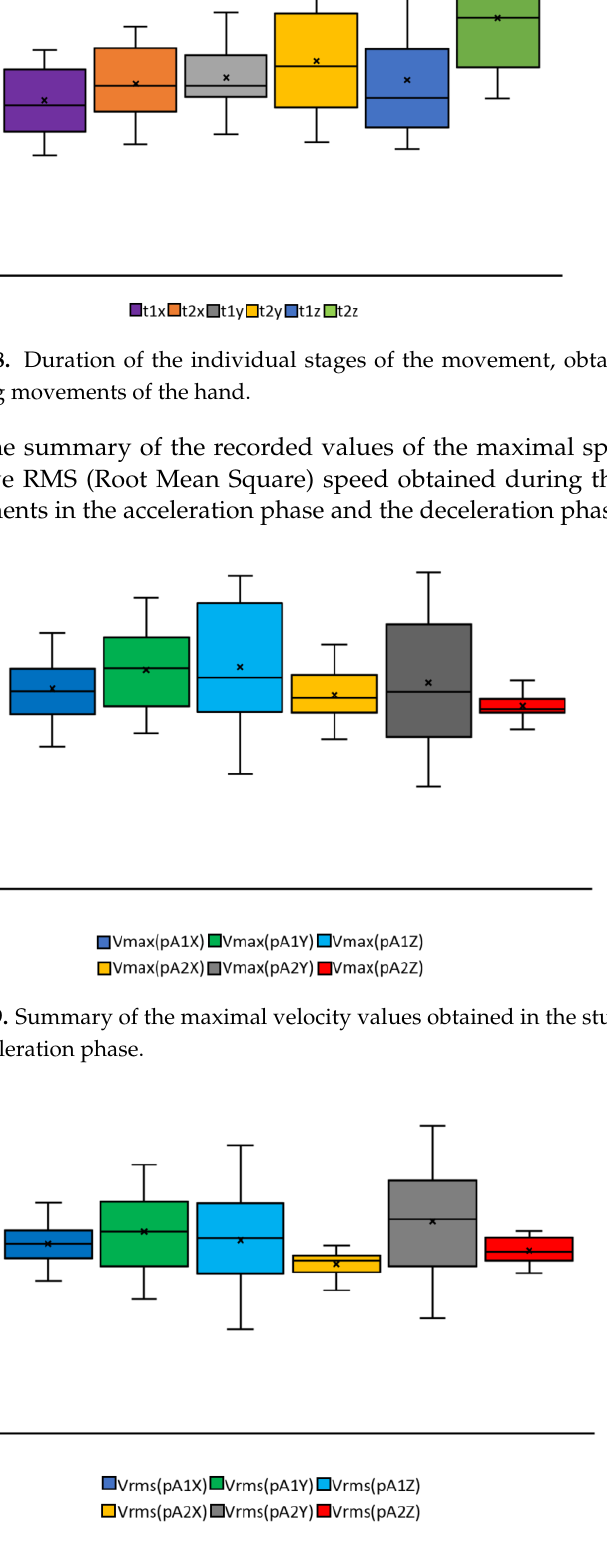
Figure 10. Summary of RMS velocity values obtained in the study of reaching movements in the acceleration phase.